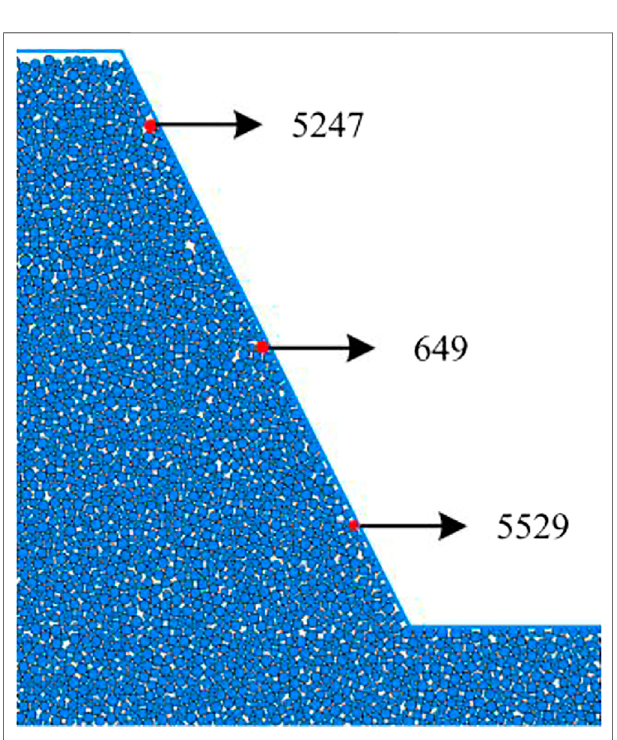
FIGURE 8 | Monitoring spheres on the slope